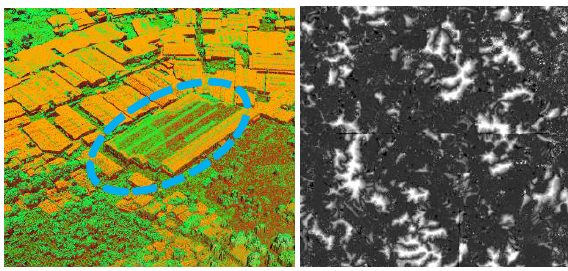
Figure 7. Sample Errors Particular to Certain